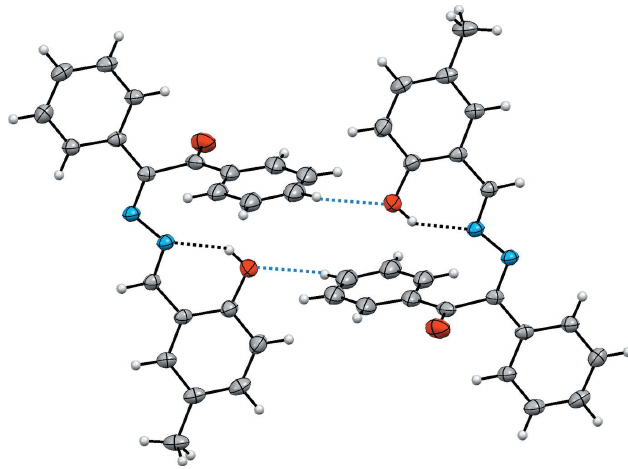
Figure 1 The molecular structure of the title compound with the atom-labelling scheme. Displacement ellipsoids are drawn at the 40% probability level. Dashed lines denote the intramolecular O—H (cid:2)(cid:2)(cid:2) N hydrogen bonds forming an S (6) ring